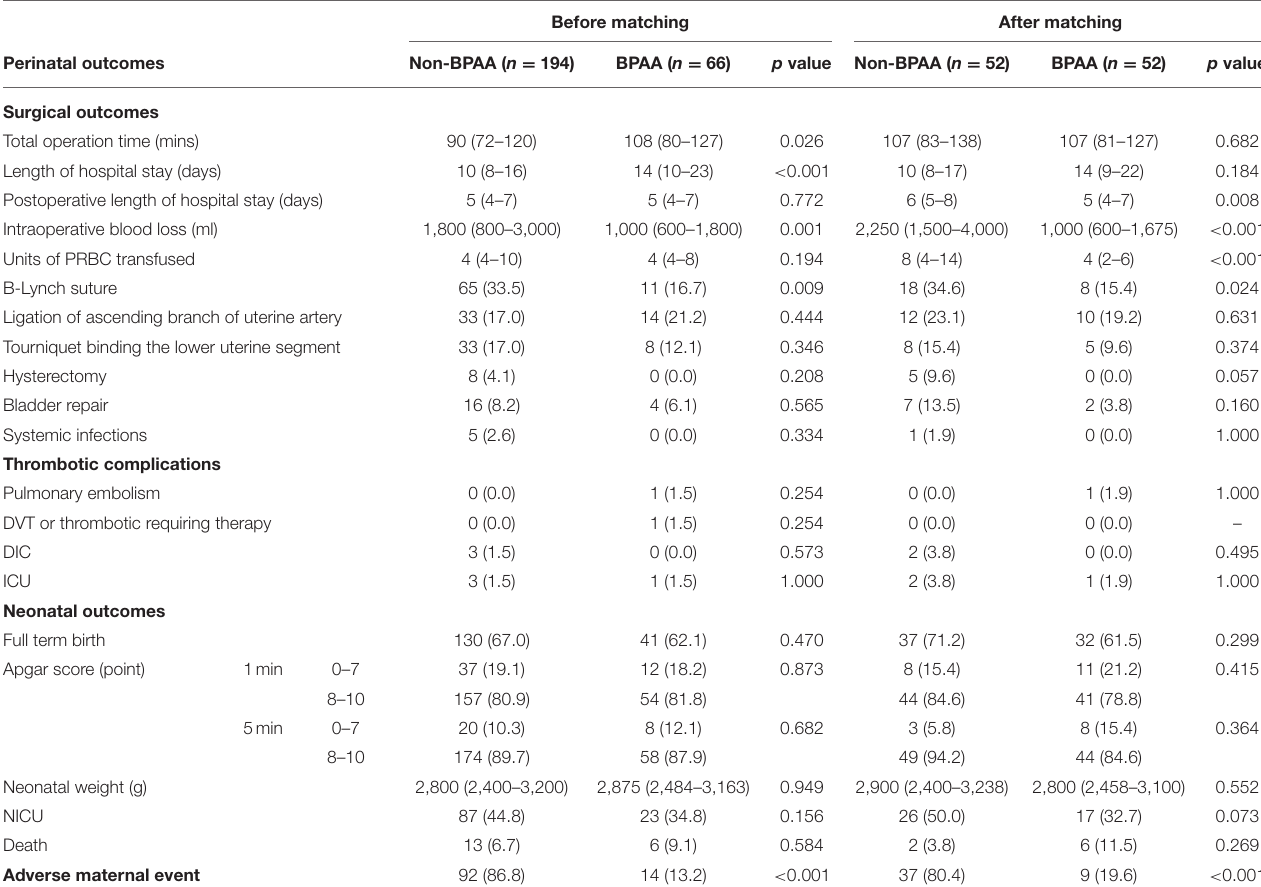
Before matching After matching